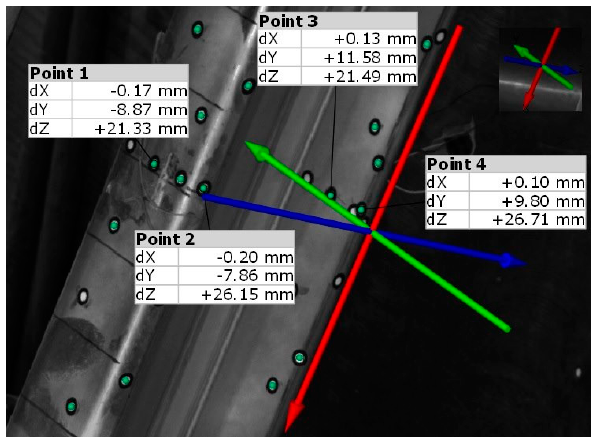
Figure 6. Displacements of individual points of cross-section in the middle of the span of one of the tested beams with a load of 25 kN.